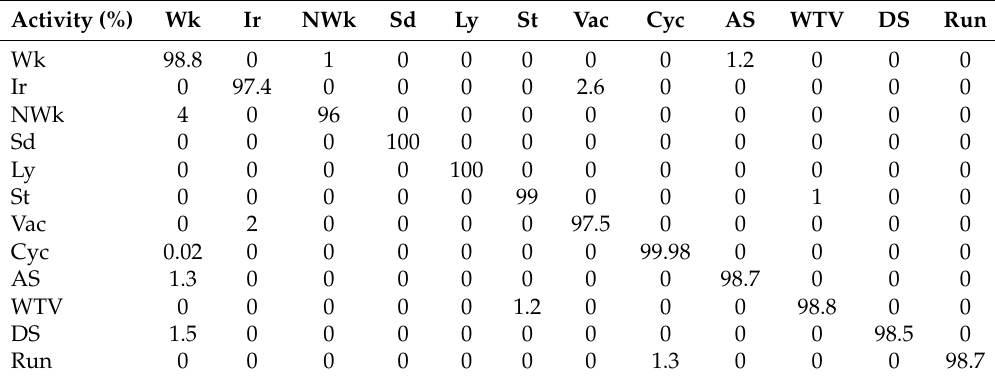
Table 4. Confusion matrix of the CNN-BiLSTM model.